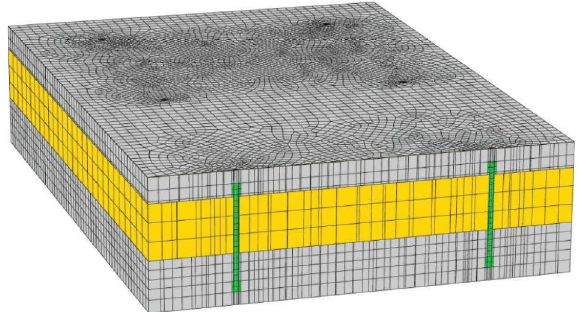
Figure 11: Finite element mesh.